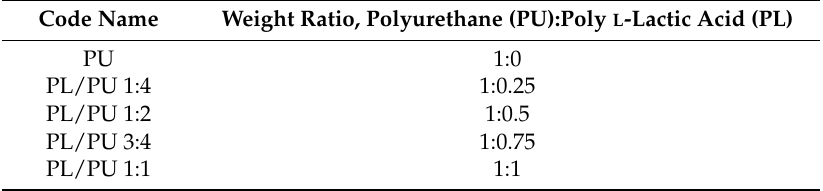
Table 1. Weight ratio of different polyurethane composites used in the investigation. Code